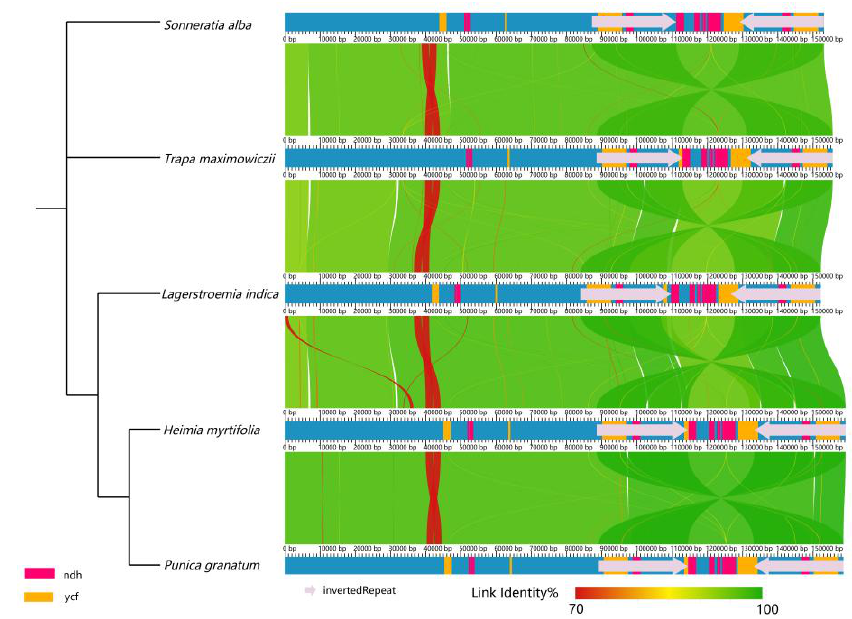
Figure 5. Co-linear analysis of five cp genomes within Lythraceae.